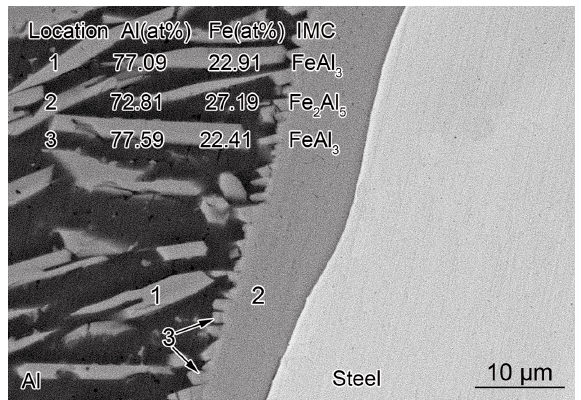
Figure 8. Back-scattered scanning electron (BSE) micrograph and energy dispersive spectrometry (EDS) analysis result of intermetallic compound (IMC) layers at the interface.